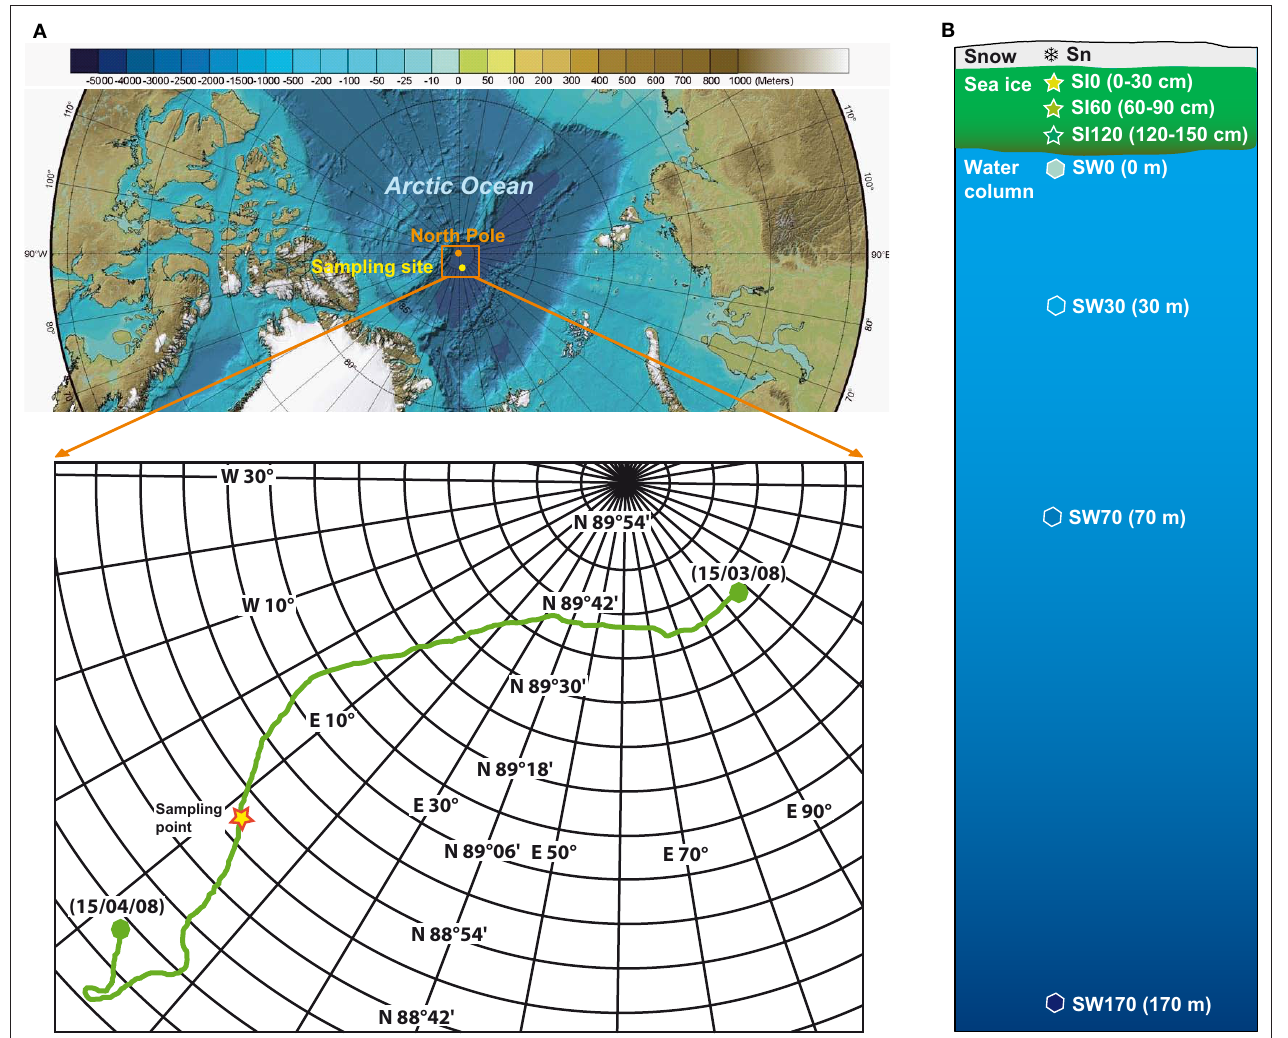
Figure 1 | Origin of samples. (A) Sampling site in the Arctic Ocean, the boxed area shows the path of the Barneo-2008 expedition; (B) profile of the sampling depths from the upper snow layer, through the ice cover, to the bottom of the euphotic zone. Base map is the International Bathymetric Chart of the Arctic Ocean (Jakobsson et al.,